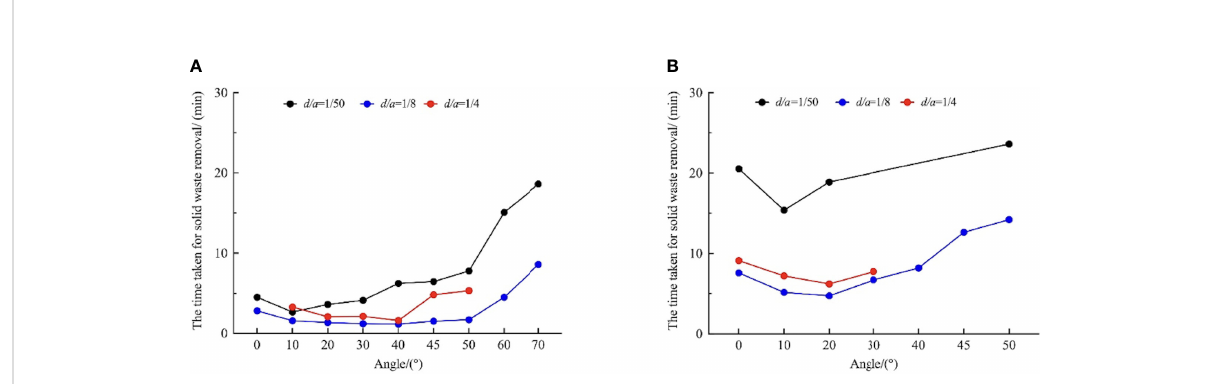
FIGURE 8 The time taken for solid waste removal under different conditions: (A) Single-inlet mode; (B) Dual-inlet mode.